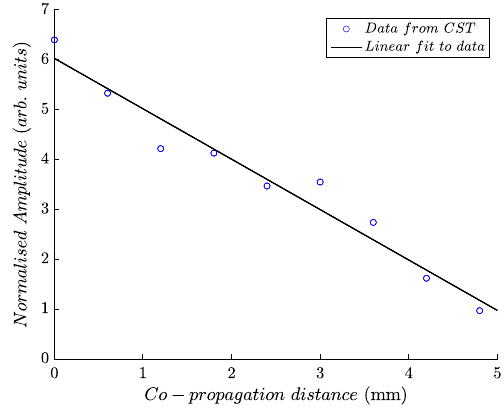
FIG. 5. The spatial profile of the THz field amplitude due to finite bandwidth as it copropagates synchronously with relativ- istic